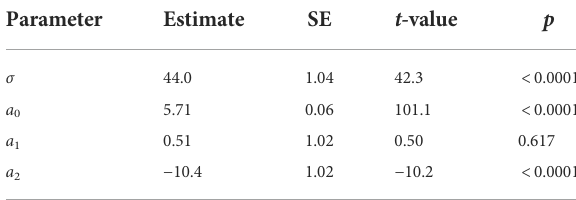
TABLE 1 Fitted parameter values and summary statistics of Eq. 2. Parameter